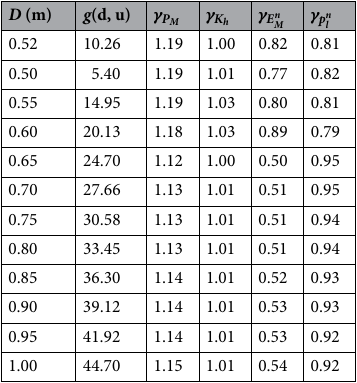
Table 5. Effect of pile diameter ( D ) on the partial factors calibrated using target reliability method ( L = 12